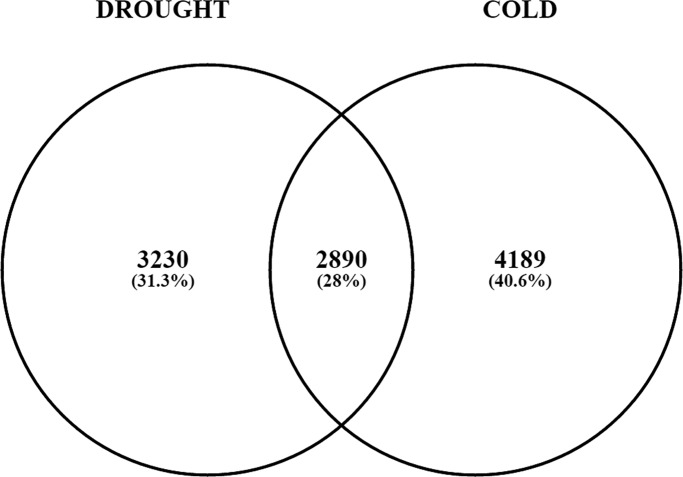
Number of unique and common differentially expressed genes (DEGs) found in A.thaliana under cold and drought stress.Total number of genes is shown in bold, below which are the percentages of genes.